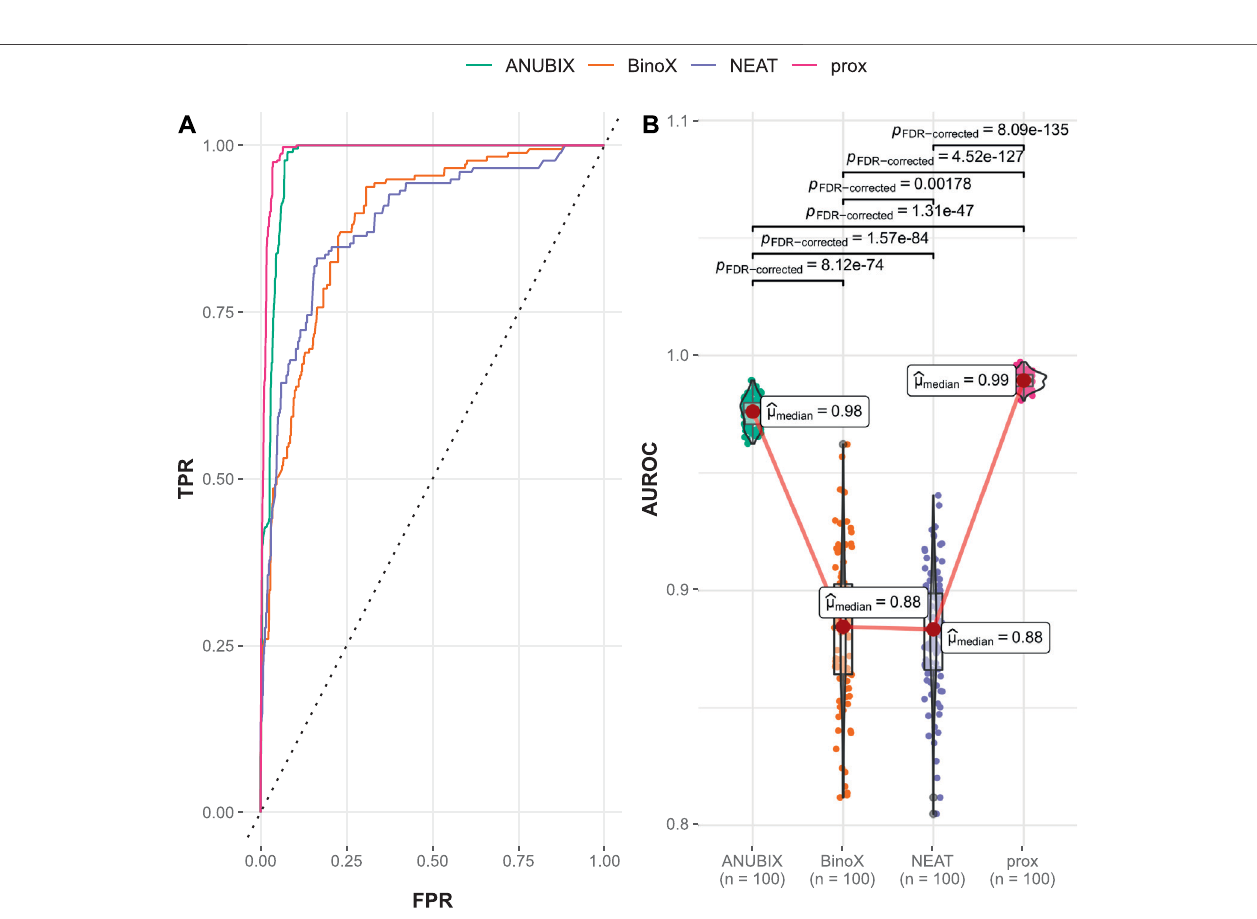
FIGURE 6 | Drug – drug similarity – based performance on the Guney2016 benchmark. Performance of the different drug repurposing tools: ANUBIX (green), BinoX (orange),NEAT(purple),andproximity(prox,pink)on (A) ROCcurves,wherethedottedlinerepresentsrandomprediction,and (B) AUROCusingsampledsetsfromthe benchmarkcontainingequal numbers ofpositive and negative drug – disease combinations. The pairwise Wilcoxon ranksum test wasused toassess thesigni fi cance of difference on AUROC. FDR-corrected p -values were obtained using the Benjamini – Hochberg procedure.